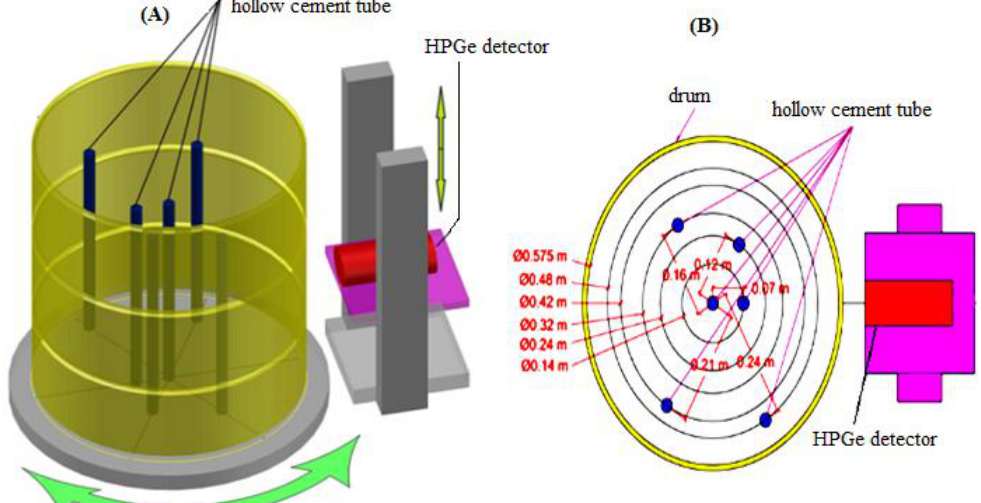
Fig.1: (A) The transparency view of drum with detector, (B): top view of drum with detector and holes